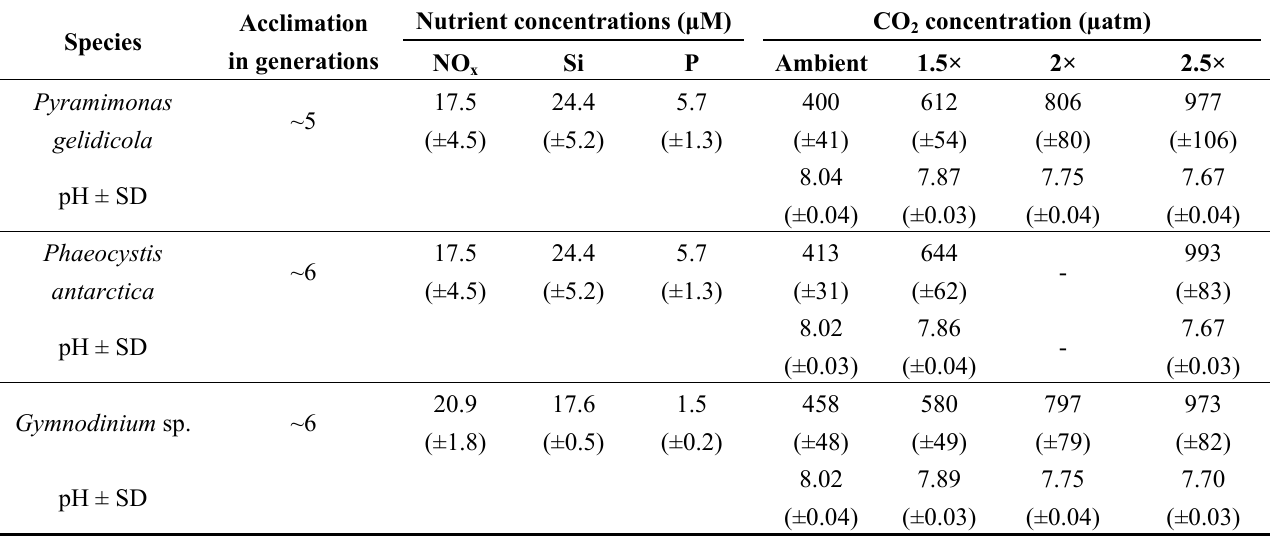
− and NO − includes NO x 3 2